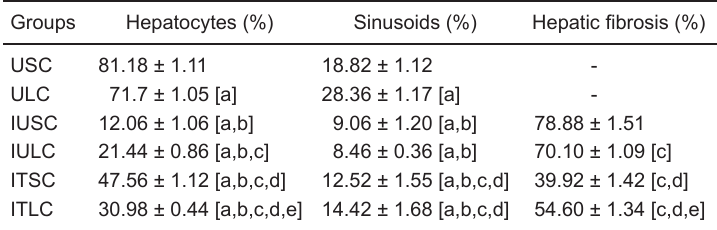
Data are reported as means ± SD in percent. For abbreviations, see legend to Table 1. Statistical comparisons (P < 0.05, Kruskal-Wallis test): [a] vs USC